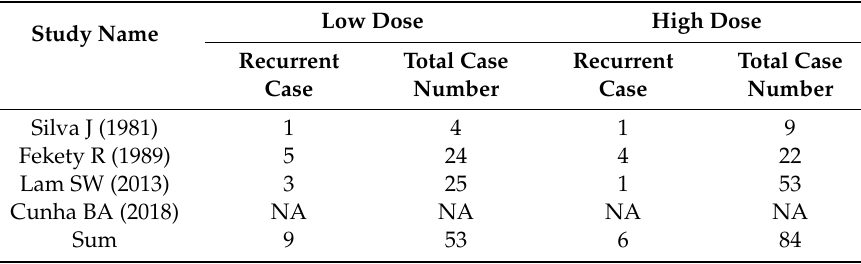
Table A2. Raw data of recurrence